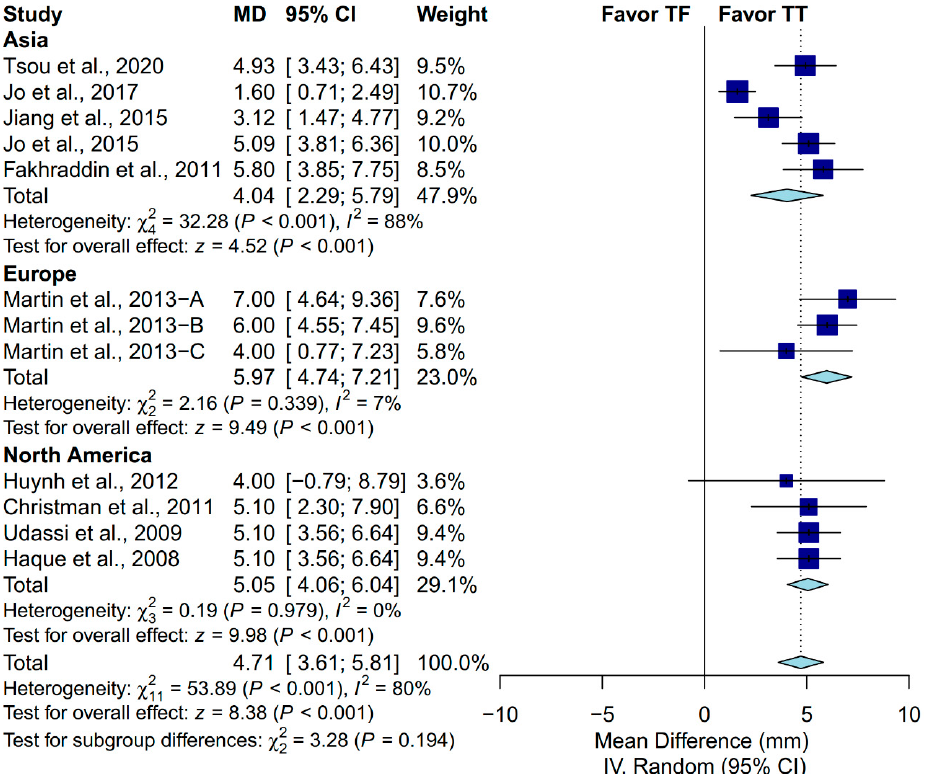
Figure 9. Subgroup analysis of chest-compression depth grouped by locale.